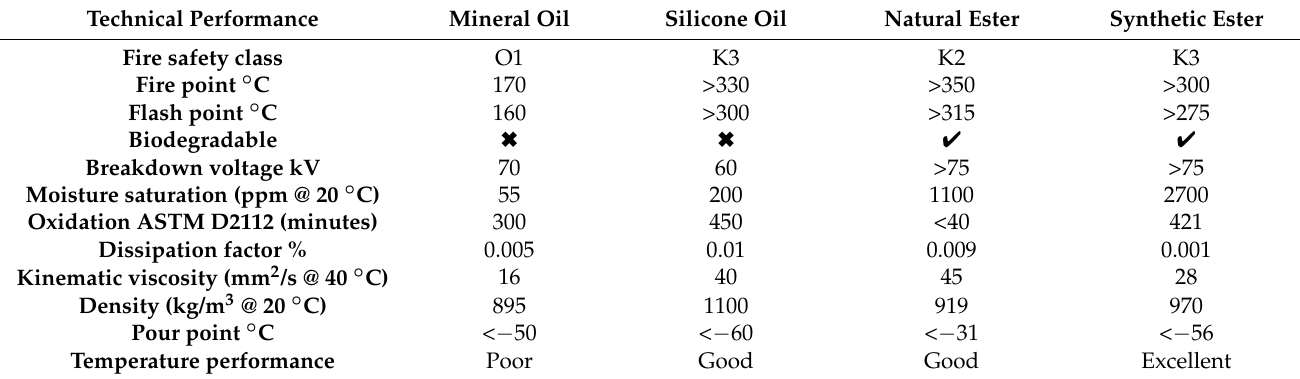
Table 1. Properties of four different insulating fluids